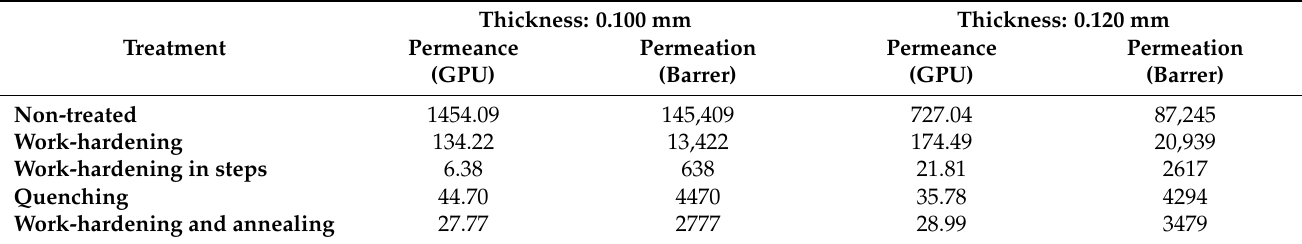
Table 3. Permeance values of metal membranes in CGS units.